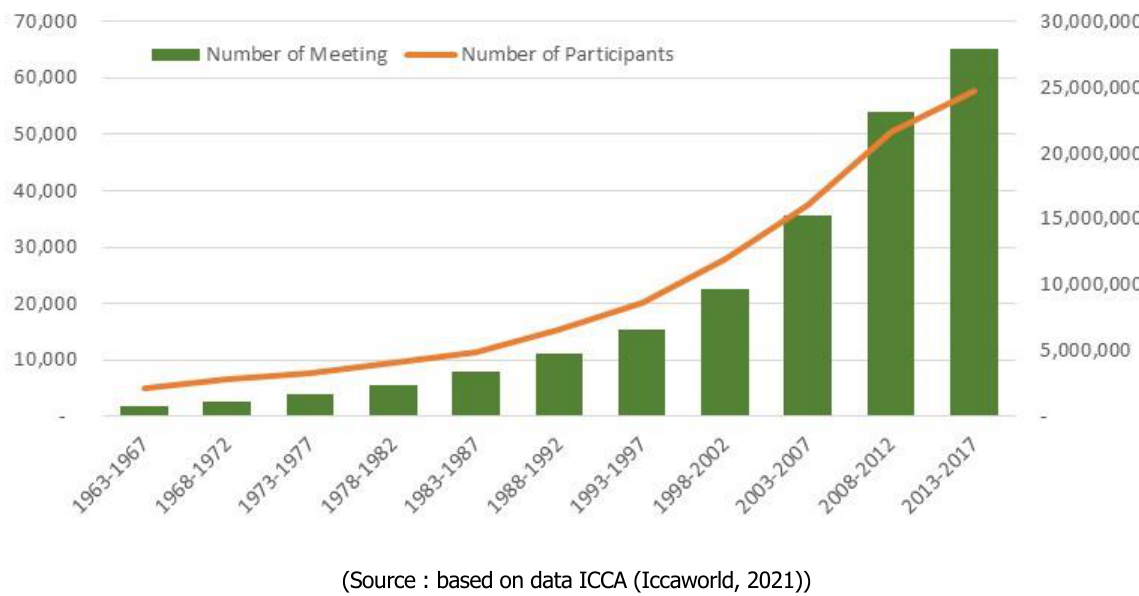
Figure.1 The Growth of International MICE Activities Before Pandemic